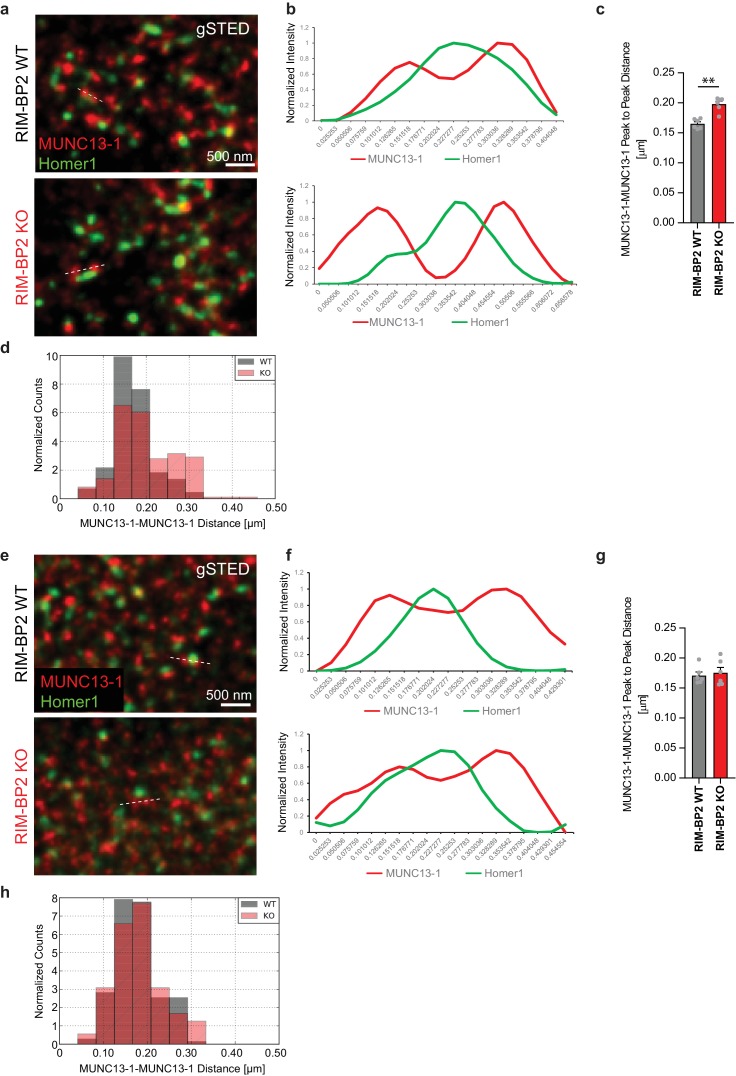
Loss of RIM-BP2 leads to an increased inter-Munc13-1 clusters distance specifically at MF synapses.(a) in situ gSTED images of Munc13-1 and Homer1 at MF synapses in RIM-BP2 WT and KO mice. Dotted line represents an example of a synapse analyzed by line profile measurement. Line profile thickness was set to ~250 nm (b) Intensity line profiles of the synapses displayed in (a). For display, intensity in each channel was normalized to its maximum after background subtraction. We analyzed 31–36 line profiles per mouse (n (WT) = 6 mice and n (KO) = 6 mice). (c) inter-Munc13-1 distances averaged per mouse analyzed. A significant increase in the distance at which two Munc13-1 clusters are found relative to each other was observed in RIM-BP2 KO as compared to WT mice. (d) Frequency histogram for all inter-Munc13-1 distances found. Counts were normalized to obtain a probability density function with an integral equal 1. (e) in situ gSTED images of Munc13-1 and Homer1 at CA3-CA1 synapses in RIM-BP2 WT and KO mice. Dotted line represents an example of a synapse analyzed by line profile measurement. Line profile thickness was set to ~250 nm (f) Intensity line profiles of the synapses displayed in (e). For display, intensity in each channel was normalized to its maximum after background subtraction. We analyzed 27–30 line profiles per mouse (n (WT) = 6 mice and n (KO) = 6 mice). (g) Inter-Munc13-1 distances averaged per mouse analyzed. At CA3-CA1 synapses, no significant difference was observed in the distance at which two Munc13-1 clusters are found relative to each other. (h) Frequency histogram for all inter-Munc13-1 distances found. Counts were normalized to obtain a probability density function with an integral equal 1. Values represent mean ± SEM. **p<0.01. For statistics please see Figure 3—figure supplement 2—source data 1.10.7554/eLife.43243.012Figure 3—figure supplement 2—source data 1.Statistics of data presented in Figure 3—figure supplement 2.